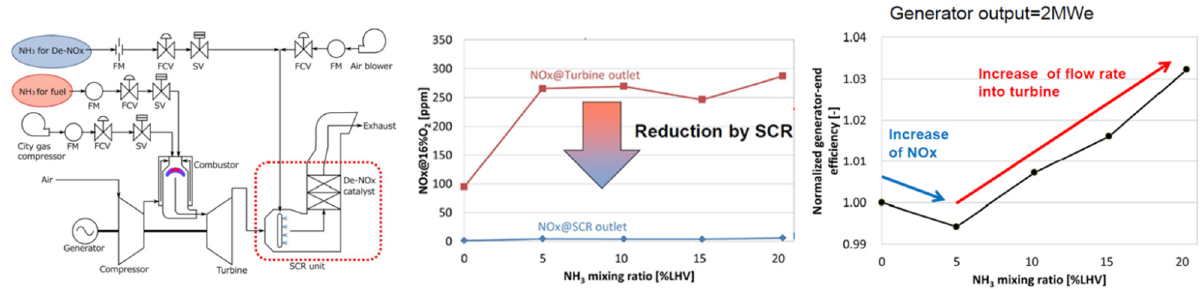
Figure 22. Schematic diagram of gas turbine system and experimental results: NOx emission and changes in power generation efficiency to the ratio of mixed NH 3 . Modified from [109]. Courtesy of Ammonia Energy Association [109].